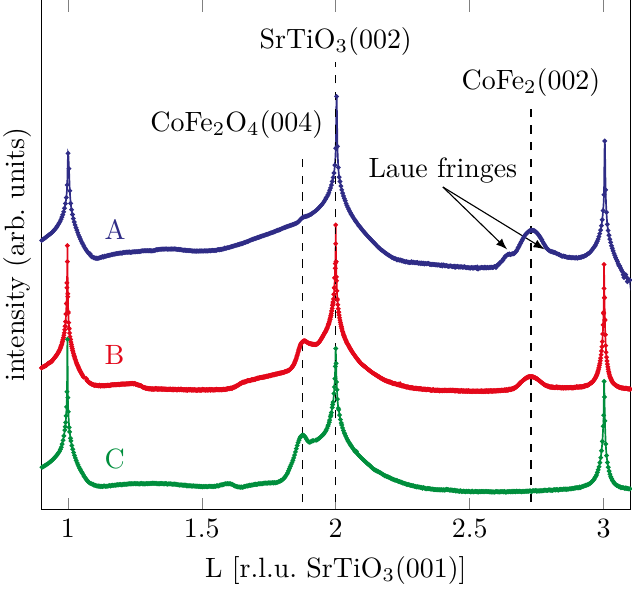
Figure 8. XRD measurements after film deposition of the different samples with varying oxygen partial